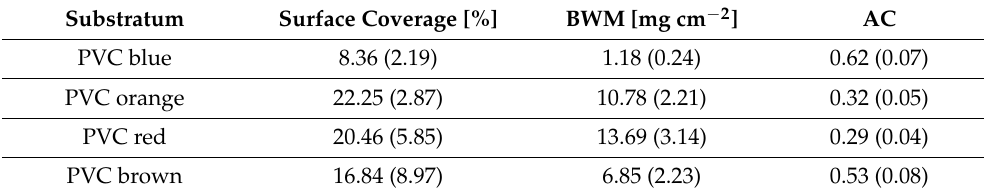
Table 2. The PVC substratum color effect on the biofilm collection efficiency (surface coverage f, biofilm wet mass (BWM), and AC). Baltic Sea studies (Gulf of Gda´nsk, August 2018); collection time 14 days; mean (standard